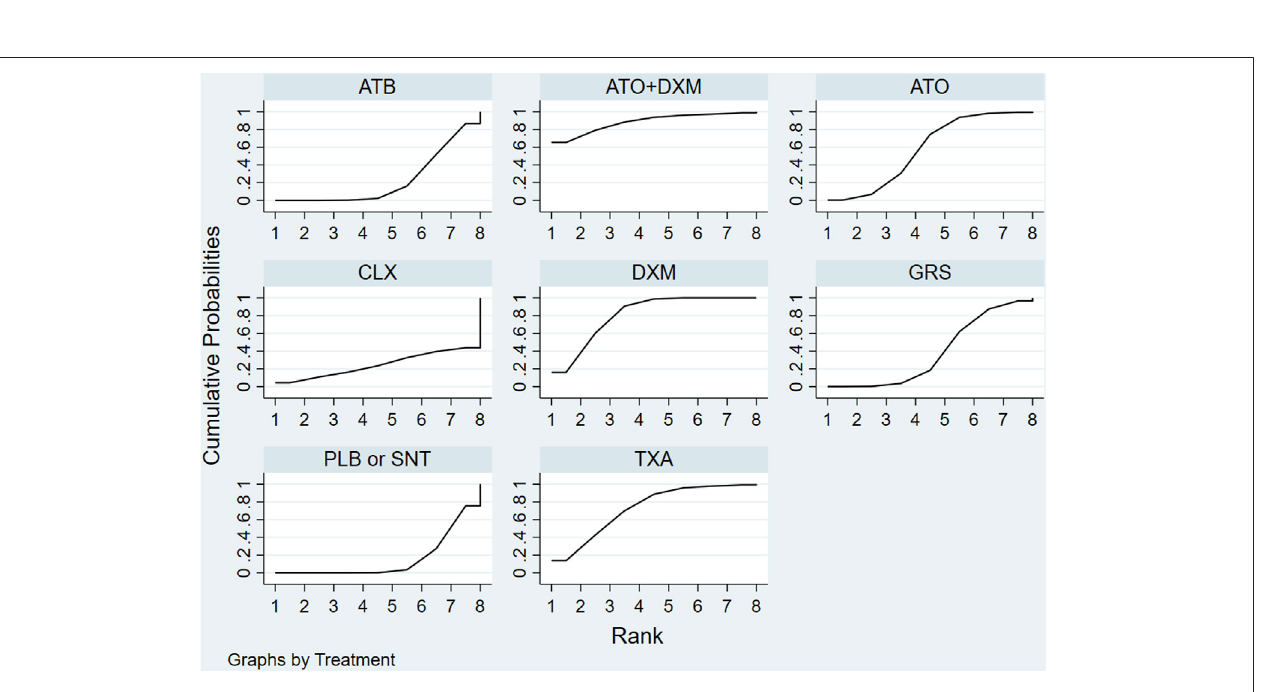
Frontiers in Pharmacology |